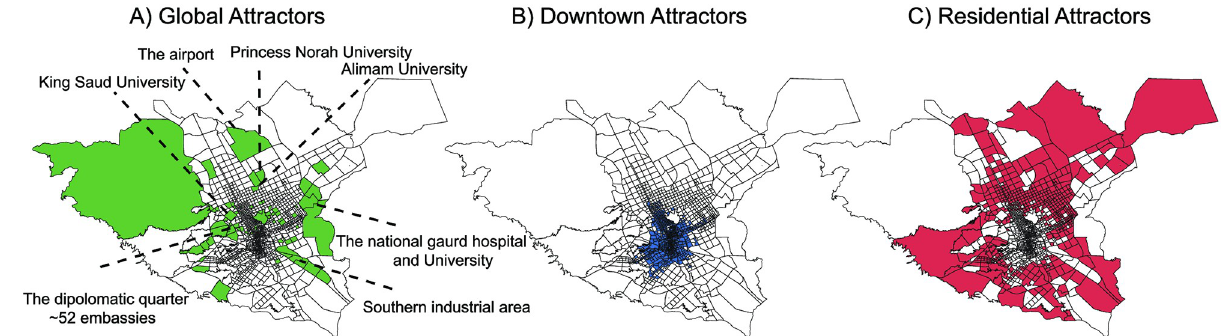
Fig 5. Types of attractors. (A) Global at tractors, which are places with a large number of visitors from all over the city traveling long distances to visit them. These include unique places in the city like the airport, large universities, hospitals, industrial areas, and the diplomatic quarter as annotated on the figure. (B) Attractors with a large number of visitors due to their central location (downtown) are more accessible, and thus the distance visitors travel to reach them is shorter. (C) Less attractive places that are located on the outer (residential) areas of the city.